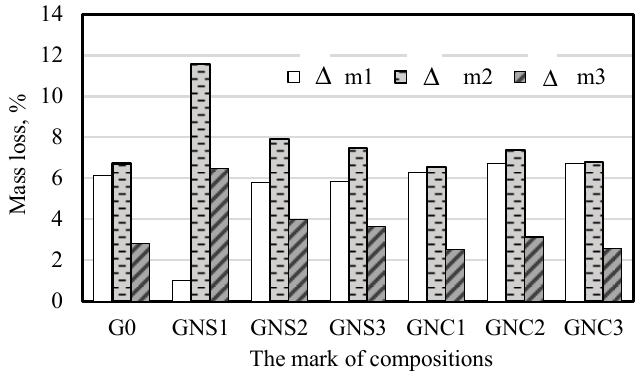
Figure 13. Mass loss at specific temperature ranges.